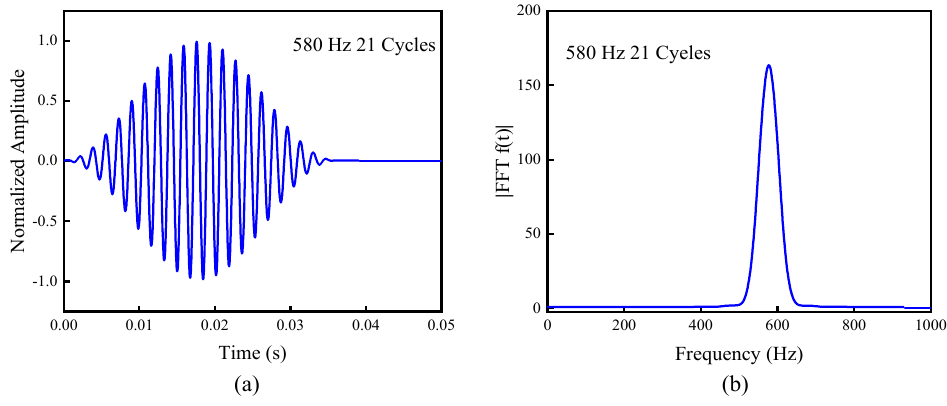
(b) Figure 14. 580 Hz, 21-cycle excitation signal response. ( a ) Time–history curve of response signal; ( b ) Fourier spectrum of response signal.